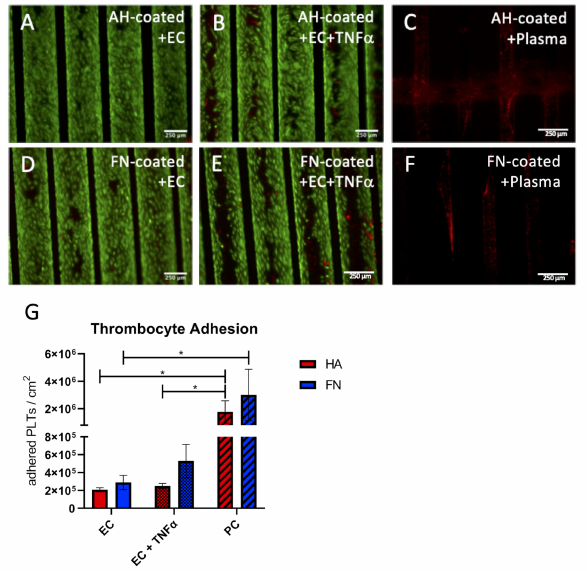
Figure 5. Platelet adhesion assay. For qualitative analysis, untreated ( A , D ), or rather TNF α stimulated ( B , E ) EC monolayers (green) on AH ( A , B ) and FN ( D , E ) coated HFM, also non-endothelialized AH ( C ) and FN coated HFM ( F ) after blood plasma immersion were incubated with thrombocytes ( red ); Scale: 250 µ m. ( G ) Quantification of adherent thrombocytes on the respective endothelialized or non-seeded positive control (PC) HFM (*: p <